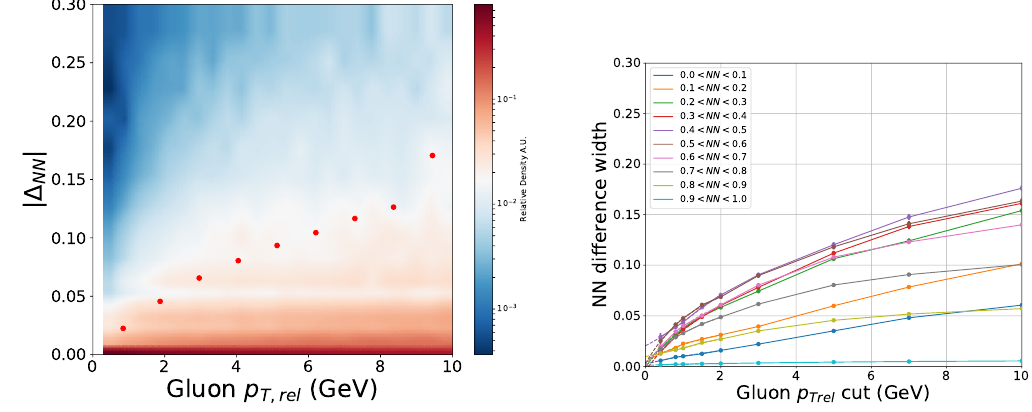
Figure 5 . Left panel: di(cid:11)erence in CNN output between merged and unmerged events, j (cid:1) NN j , as a function of the gluon transverse momentum relative to its nearest quark, p g width of the j (cid:1) NN j distribution. Background colors indicate the relative density of events for given p g . Right panel: j (cid:1) NN j width as a function of p g T lines indicate an interpolating curve (third-order polynomial) (cid:12)t to the data in each NN output bin. 90% of the events in that bin have j (cid:1)